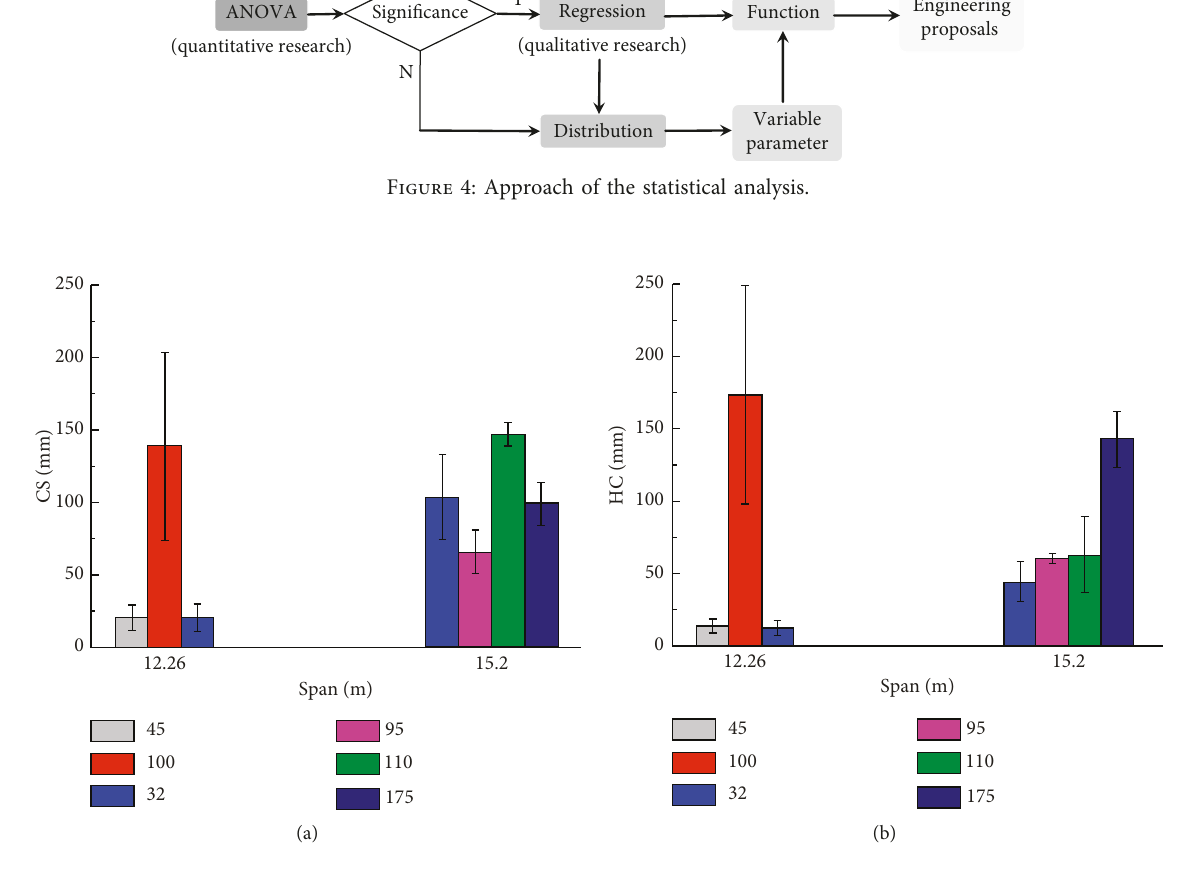
Figure 5: Variation of deformation with cover